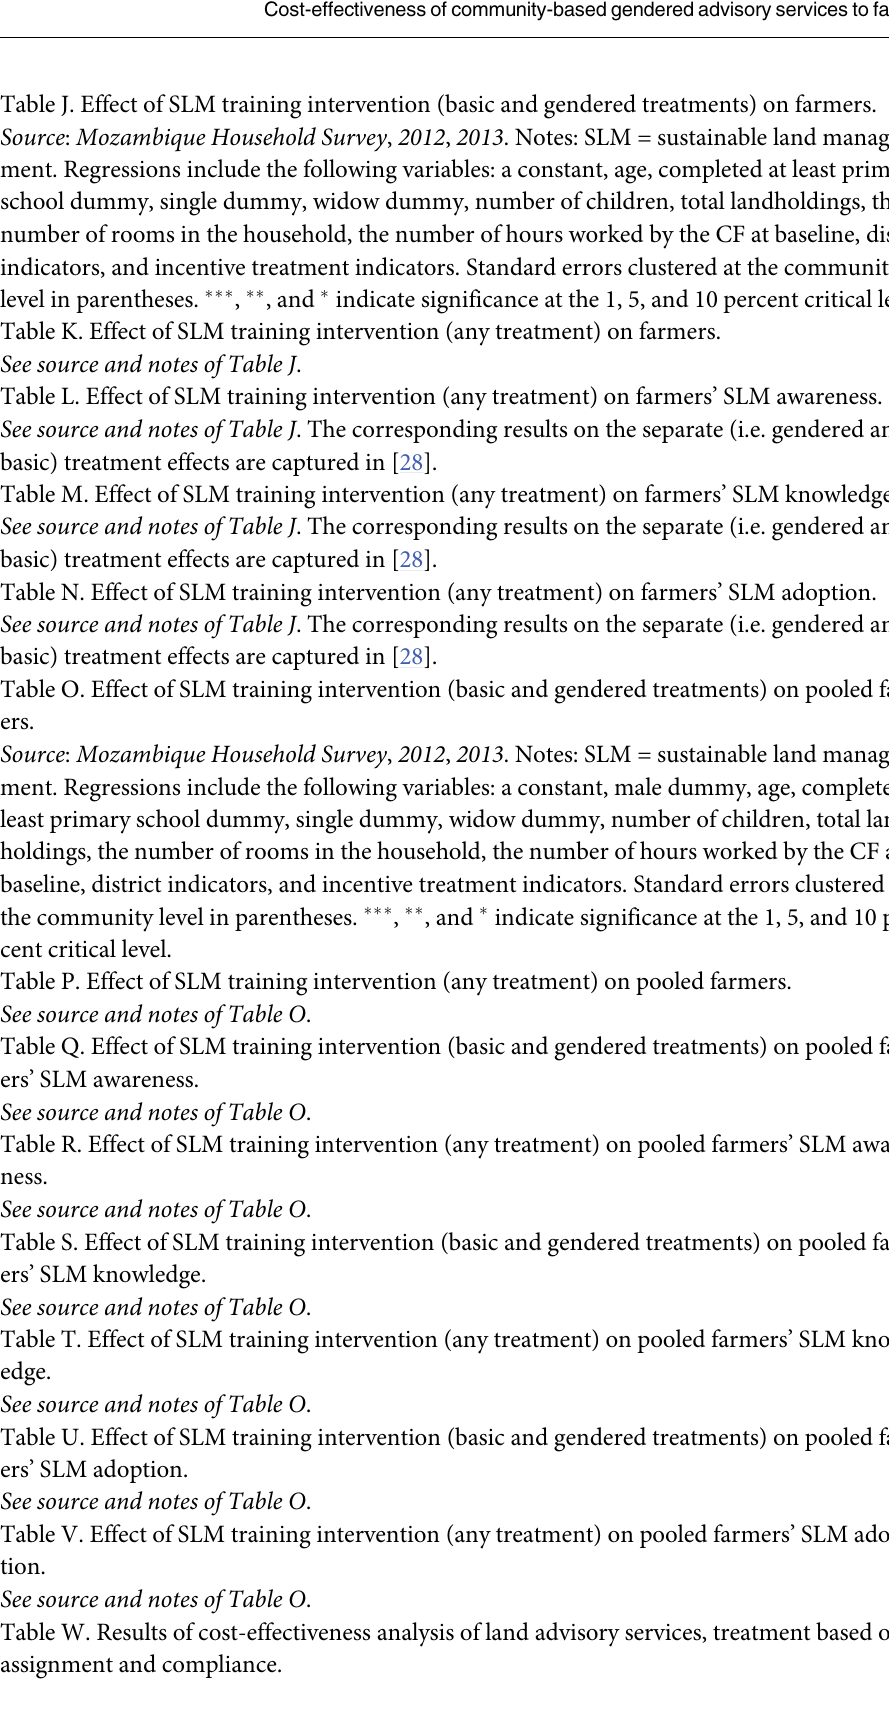
Table J. Effect of SLM training intervention (basic and gendered treatments) on farmers. Source : Mozambique Household Survey , 2012 , 2013 . Notes: SLM = sustainable land manage- ment. Regressions include the following variables: a constant, age, completed at least primary school dummy, single dummy, widow dummy, number of children, total landholdings, the number of rooms in the household, the number of hours worked by the CF at baseline, district indicators, and incentive treatment indicators. Standard errors clustered at the community level in parentheses. ��� , �� , and � indicate significance at the 1, 5, and 10 percent critical level. Table K. Effect of SLM training intervention (any treatment) on farmers. See source and notes of Table J . Table L. Effect of SLM training intervention (any treatment) on farmers’ SLM awareness. See source and notes of Table J . The corresponding results on the separate (i.e. gendered and basic) treatment effects are captured in [28]. Table M. Effect of SLM training intervention (any treatment) on farmers’ SLM knowledge. See source and notes of Table J . The corresponding results on the separate (i.e. gendered and basic) treatment effects are captured in [28]. Table N. Effect of SLM training intervention (any treatment) on farmers’ SLM adoption. See source and notes of Table J . The corresponding results on the separate (i.e. gendered and basic) treatment effects are captured in [28]. Table O. Effect of SLM training intervention (basic and gendered treatments) on pooled farm- ers.